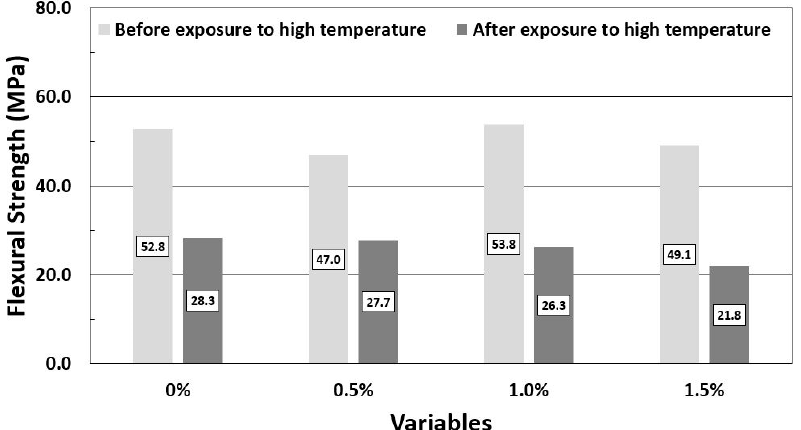
Figure 7. Flexural strength of the specimen before and after high temperature exposure with polymer content (%).